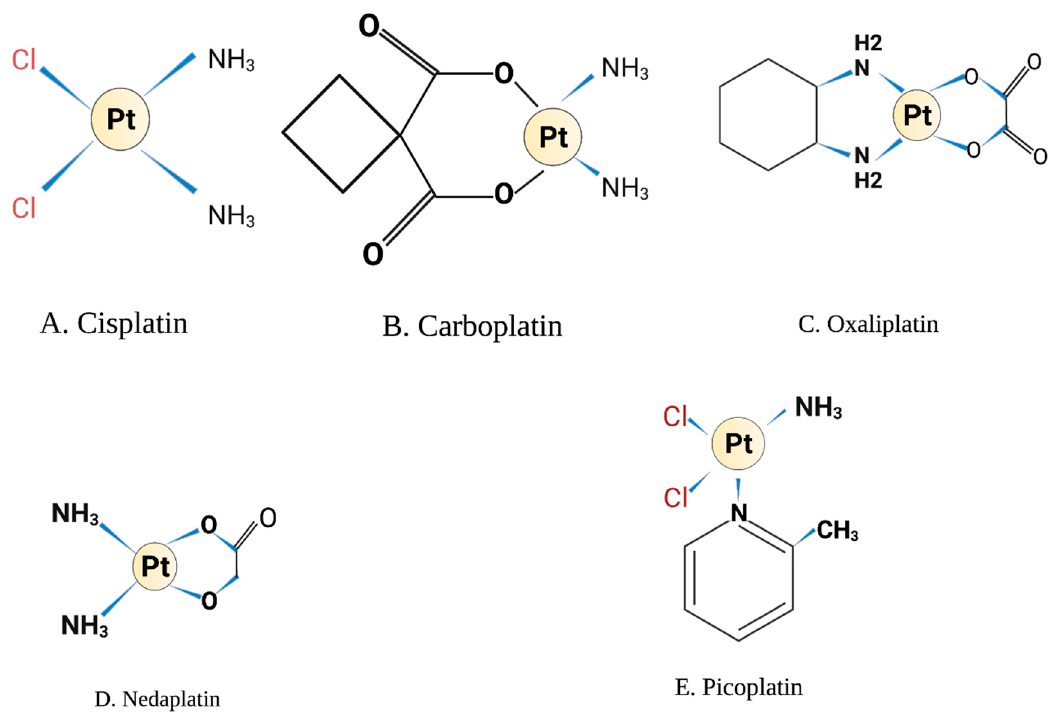
Figure 1. Chemical structure. Illustrations created by BioRender.com (accessed on 8 May 2022).